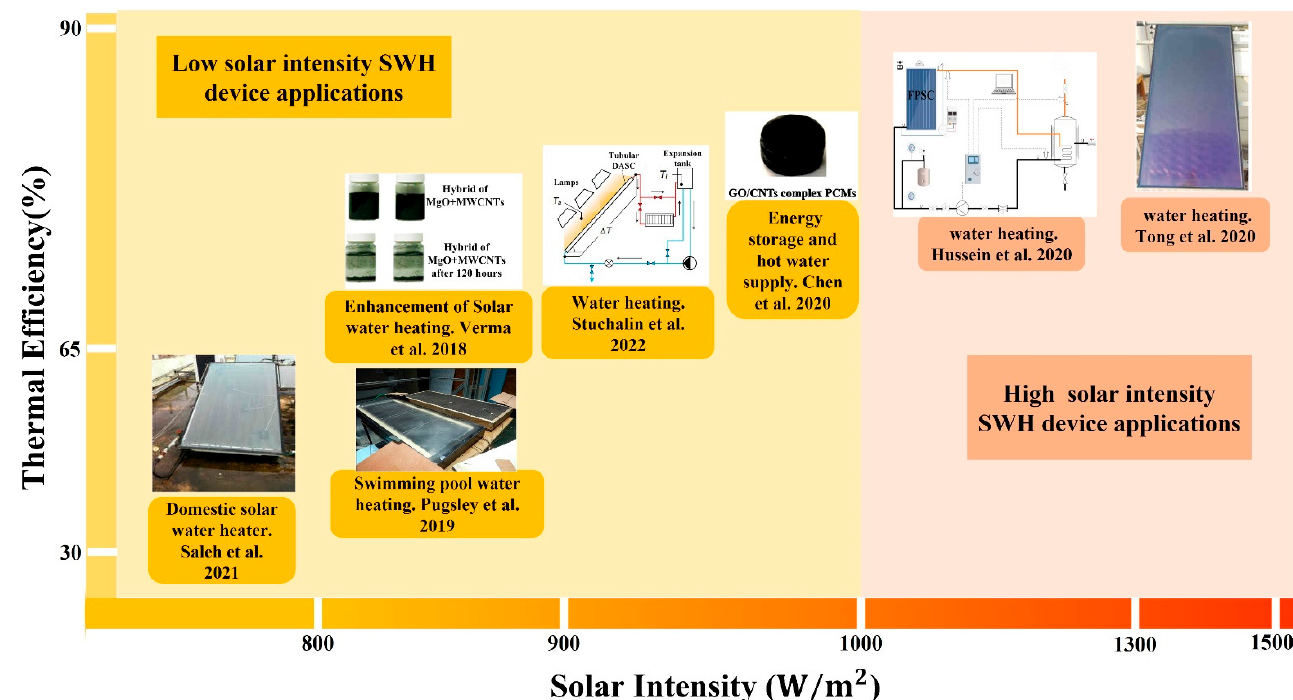
Figure 9. Application of CNT-based solar water heating (SWH) devices (reproduced with permis-